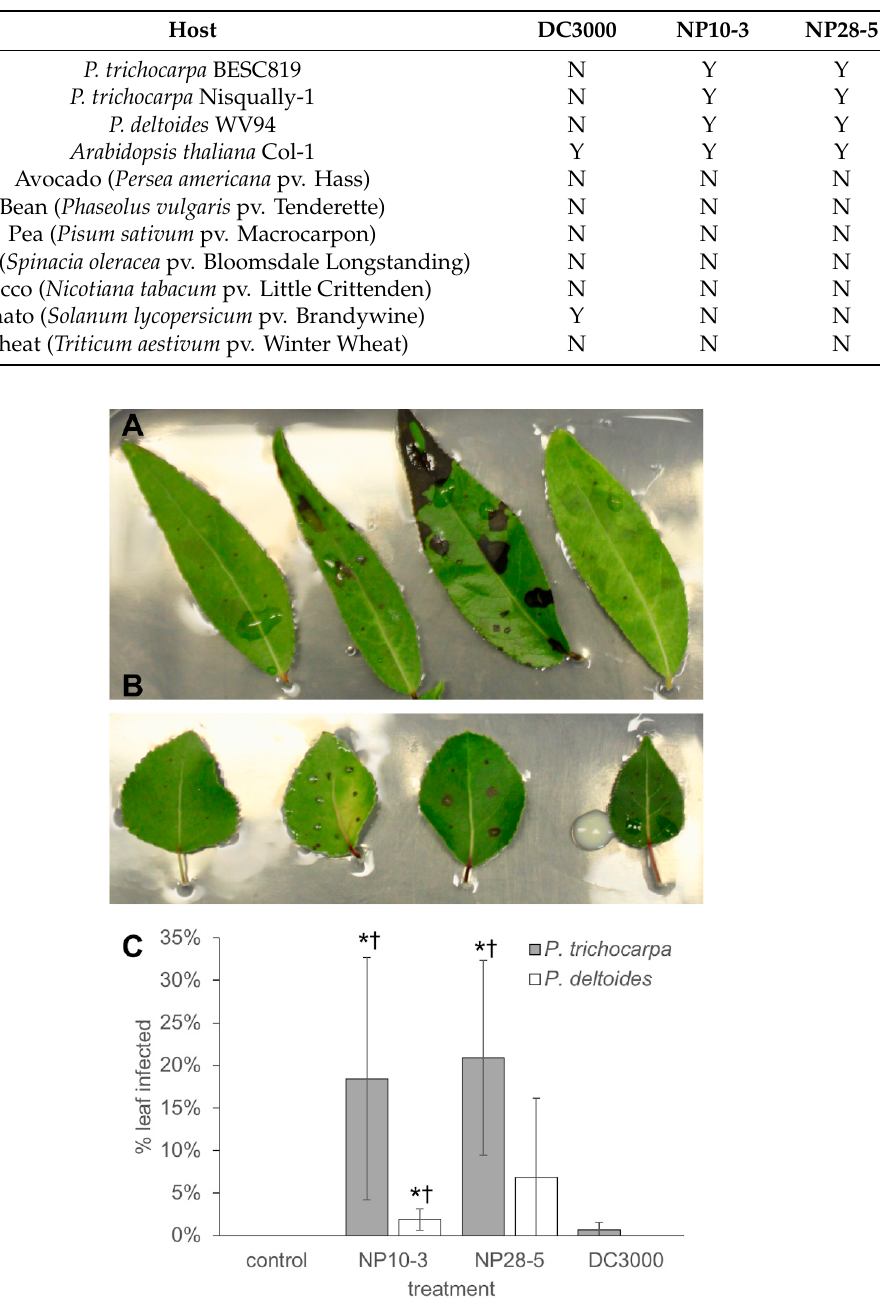
Table 4. Scope of pathogenicity of Populus trichocarpa isolates NP10-3 and NP28-5. Pseudomonas syringae pv. tomato DC3000 was used as a comparison.